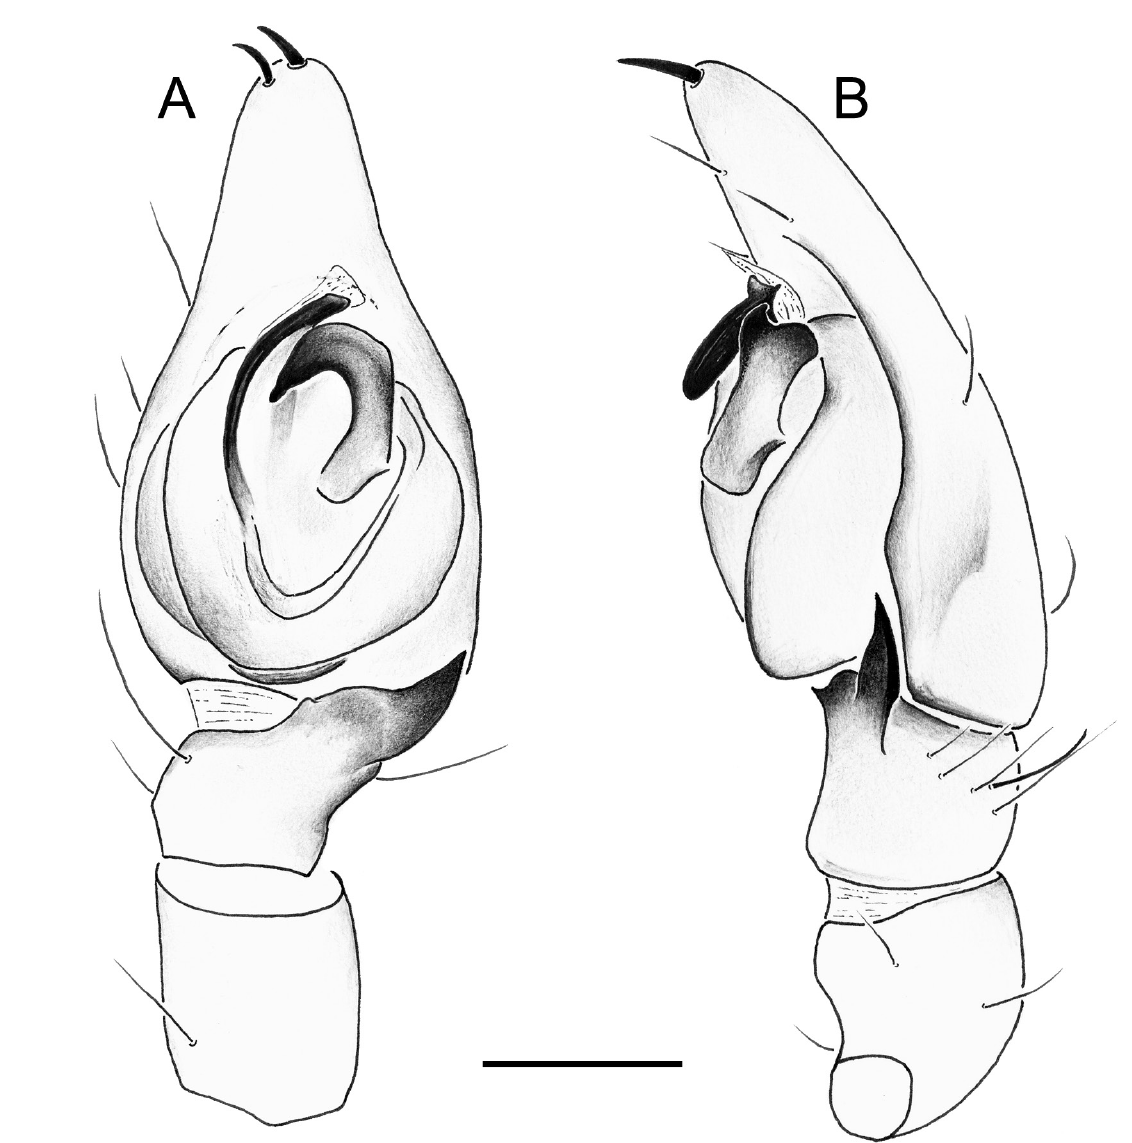
Fig. 11. Acanthinozodium quercicola sp. nov., holotype ♂, palp. A . Ventral view. B . Retrolateral view. Scale bar = 0.2